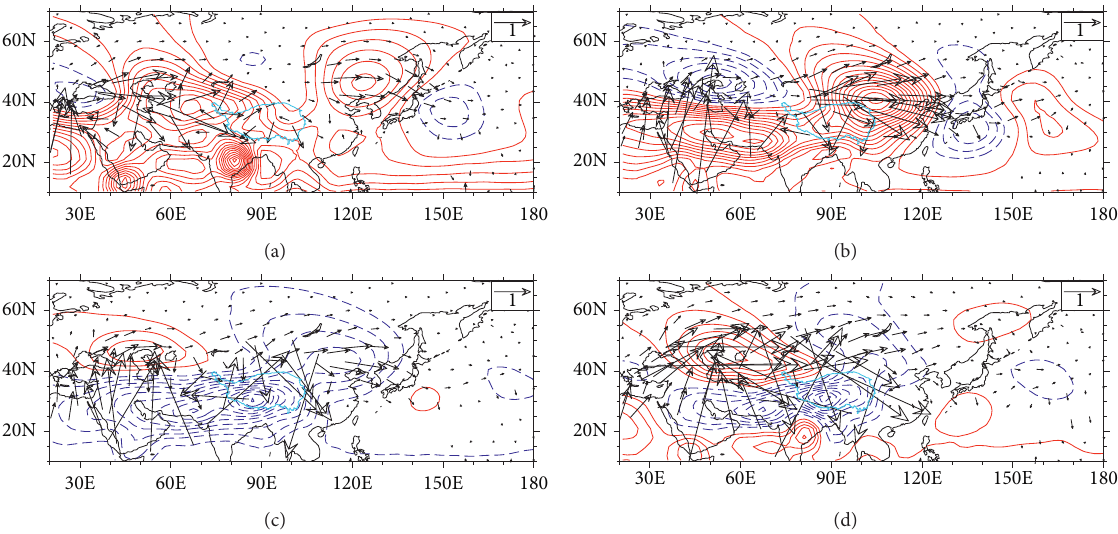
Figure 12: The QG (contours, units: 10 6 m 2 · s − 1 ) and TNF (vectors, units: m 2 · s − 2 ) at 200hPa for (a) INH, (b) TPH, (c) TPC, and (d) COM experiments.